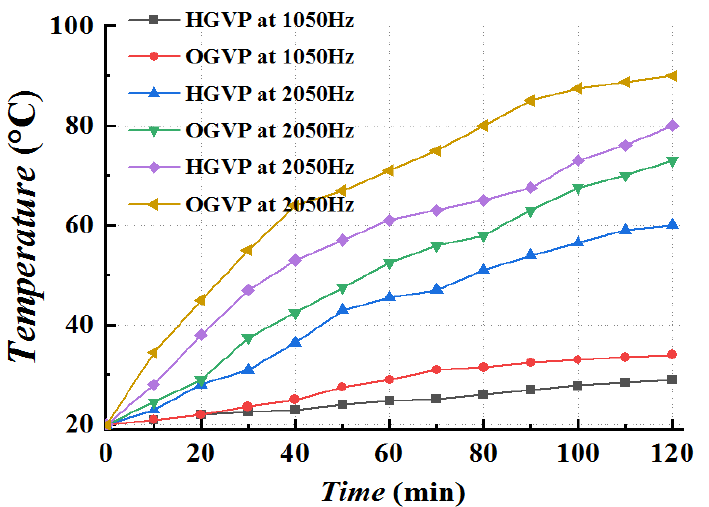
Figure 15. The maximum temperature of ordinary-gradient and high-gradient valve under high frequency condition.